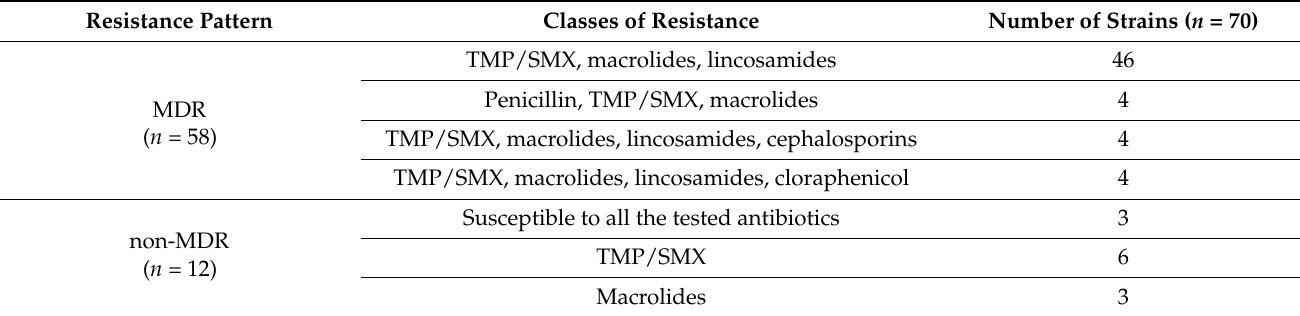
Table 3. Multidrug resistance patterns of Streptoccocus pneumoniae